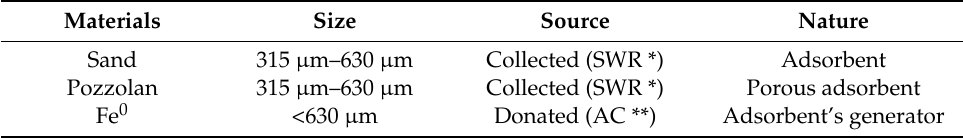
Table 1. Size, source, and nature of the three tested materials. The main selection criterion was local availability. Materials Size Source Nature Sand Collected (SWR *) Adsorbent